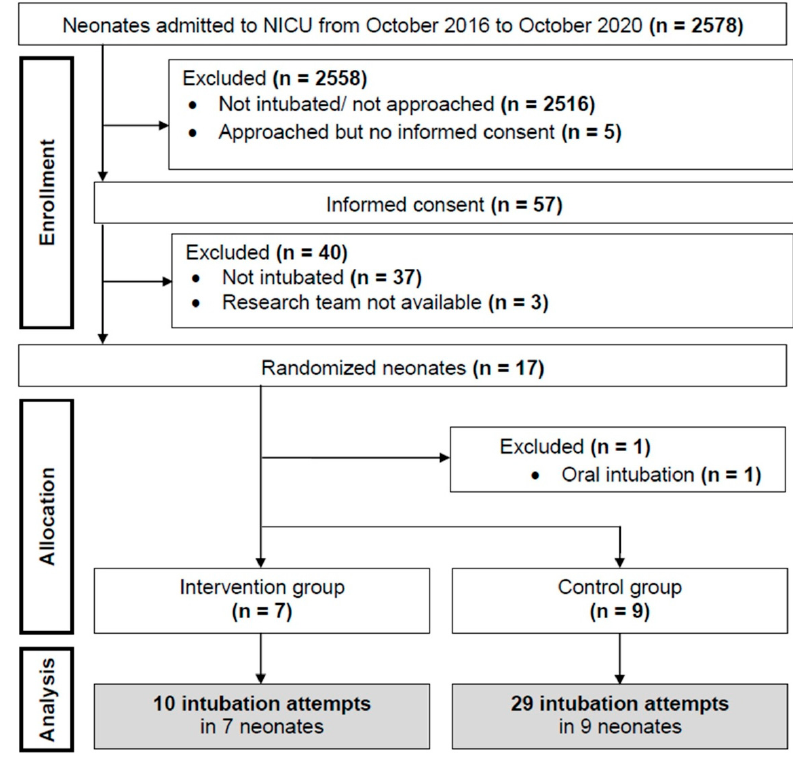
Figure 1. Flow Figure 1. Flow Chart.